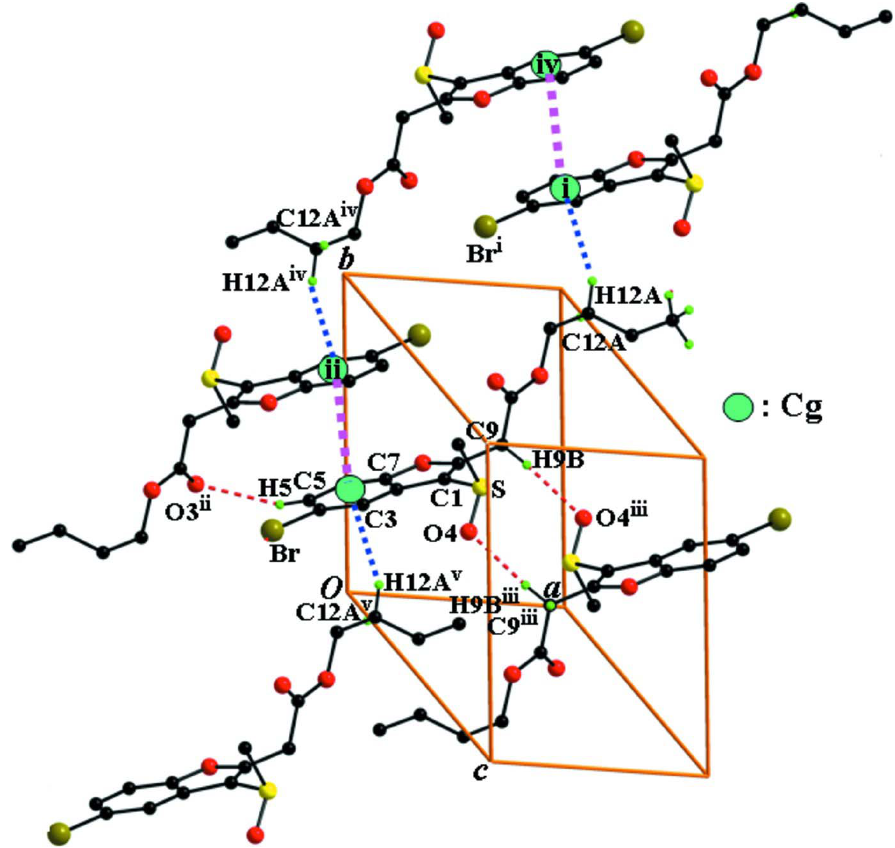
Diagram illustrating the π — π , C—H··· π and C—H···O interactions (dotted lines) in the crystal structure of (I). Cg denotes a ring centroid. The disordered component of the butyl group, part B, has been omitted for clarity as have H atoms not involved in intermolecular contacts. Symmetry codes: (i) x + 1, y + 1, z ; (ii) - x , 1 - y , - z ; (iii) - x + 1, - y + 1, - z + 1; (iv) - x + 1, - y + 2, - z ; (v) x - 1, y - 1, z